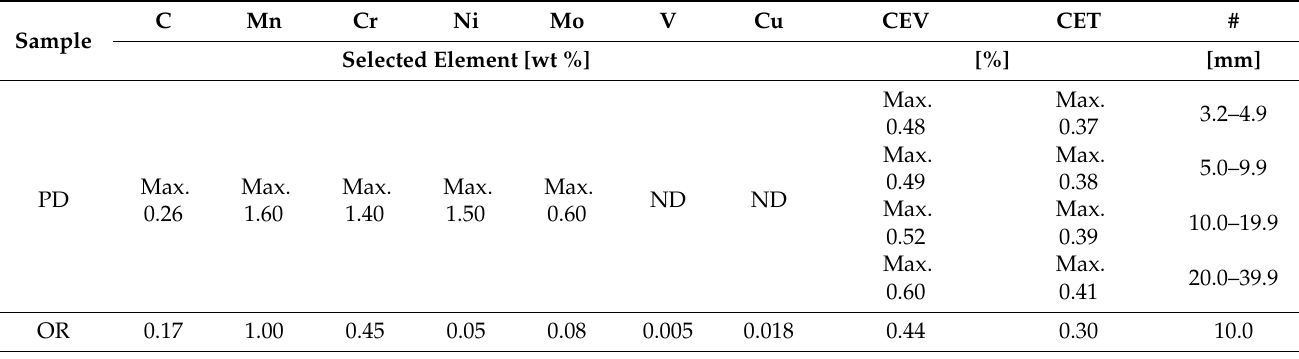
Table 1. Chemical composition and carbon equivalents of Hardox 450 plates: PD—manufacturer’s data [1], OR—own test results, #—plate thickness, CEV—carbon equivalent according to IIW, CET—carbon equivalent according to SS-EN 1011-2, ND—no data.